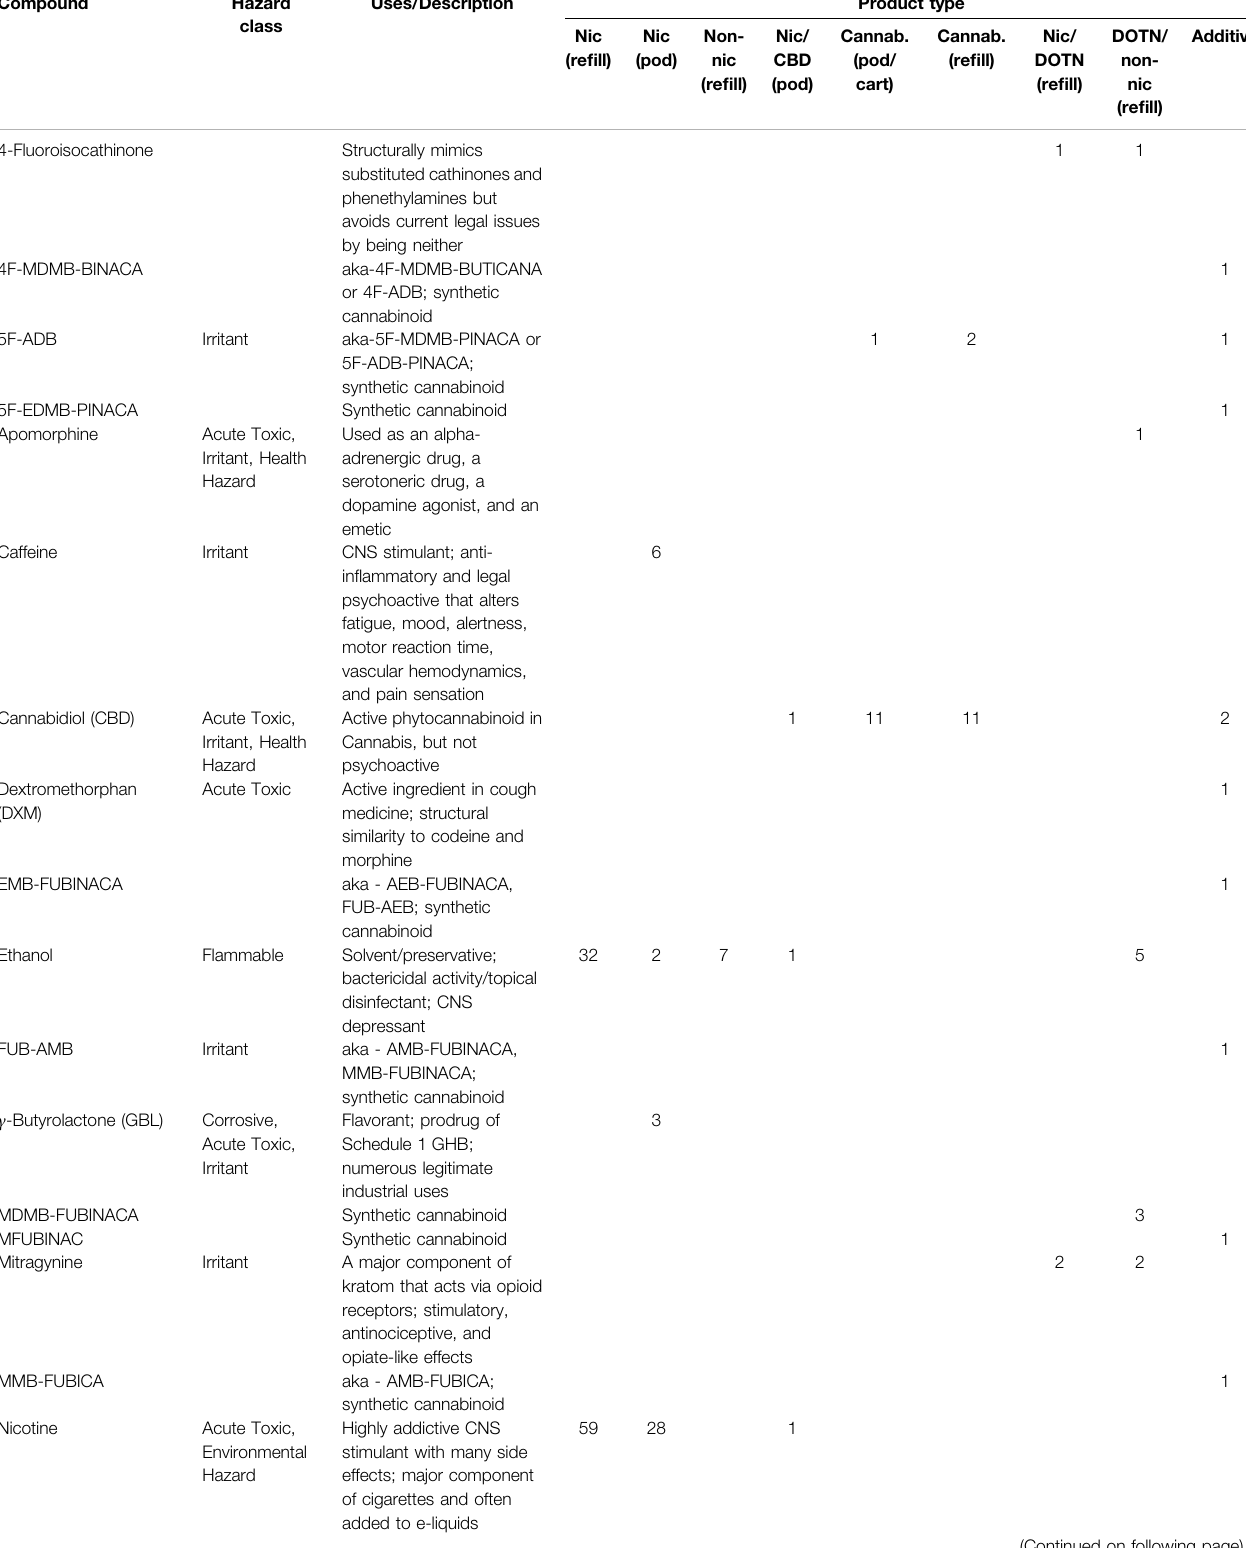
TABLE 1 | Pharmalogically active chemicals identi fi ed in products through screening, with product type and frequency of detection.